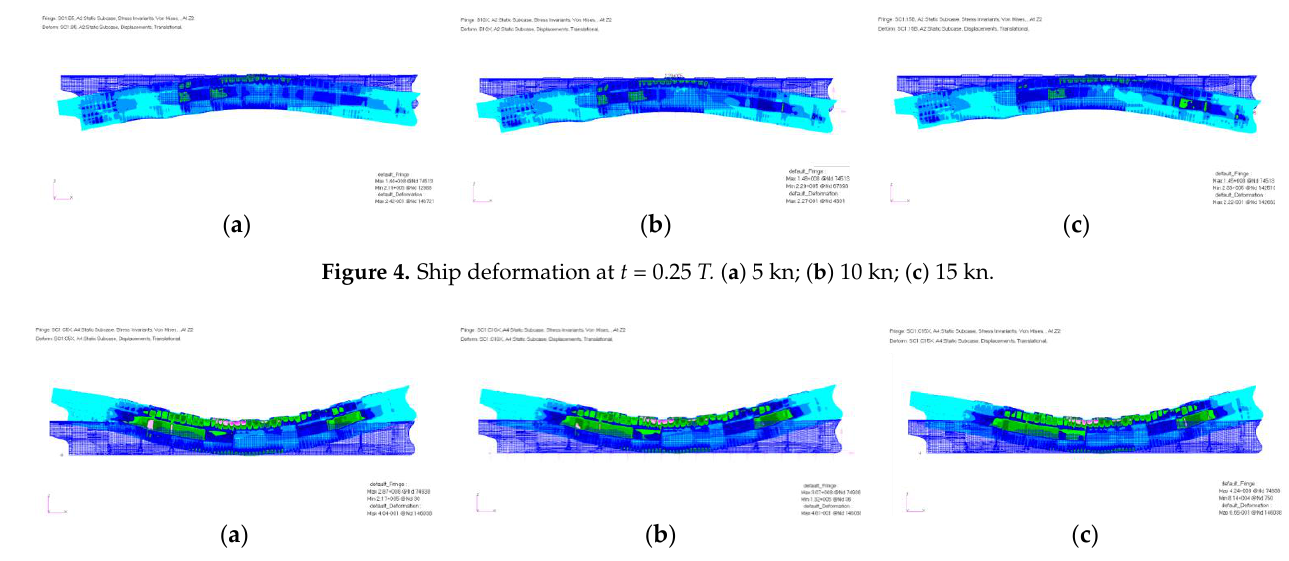
Figure 3. Ship deformation at t = 0.125 T. ( a ) 5 kn; ( b ) 10 kn; ( c ) 15 kn.